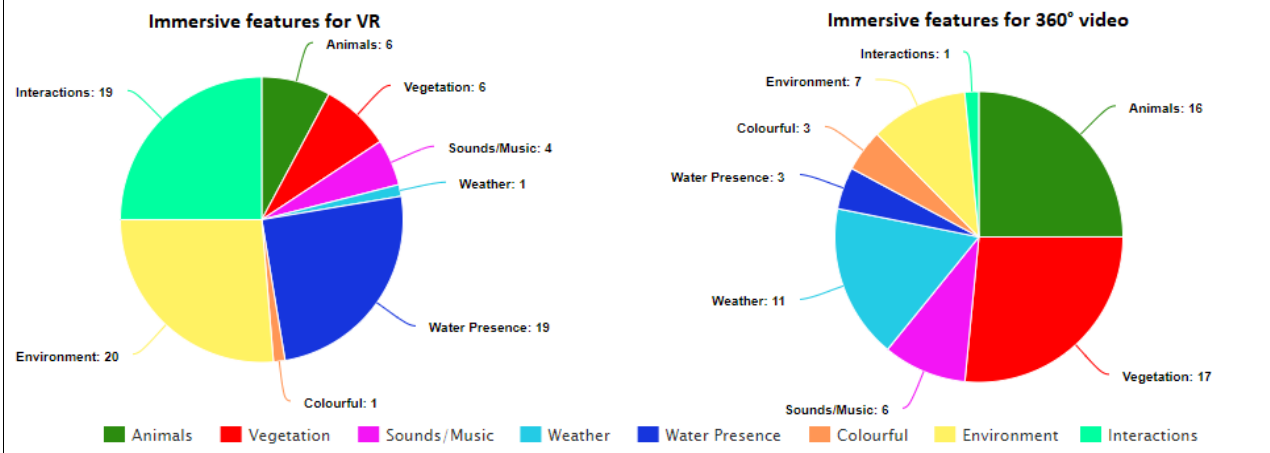
Figure 6. Immersive features highlighted by participants on both experiences.